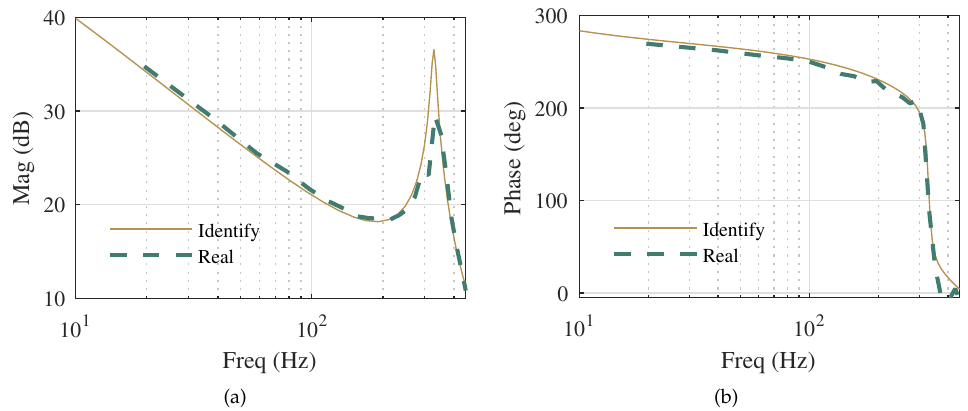
Figure 5. Frequency responses of the single axis motion platform, amplitude and phase frequency responses are separately represented by ( a , b ).